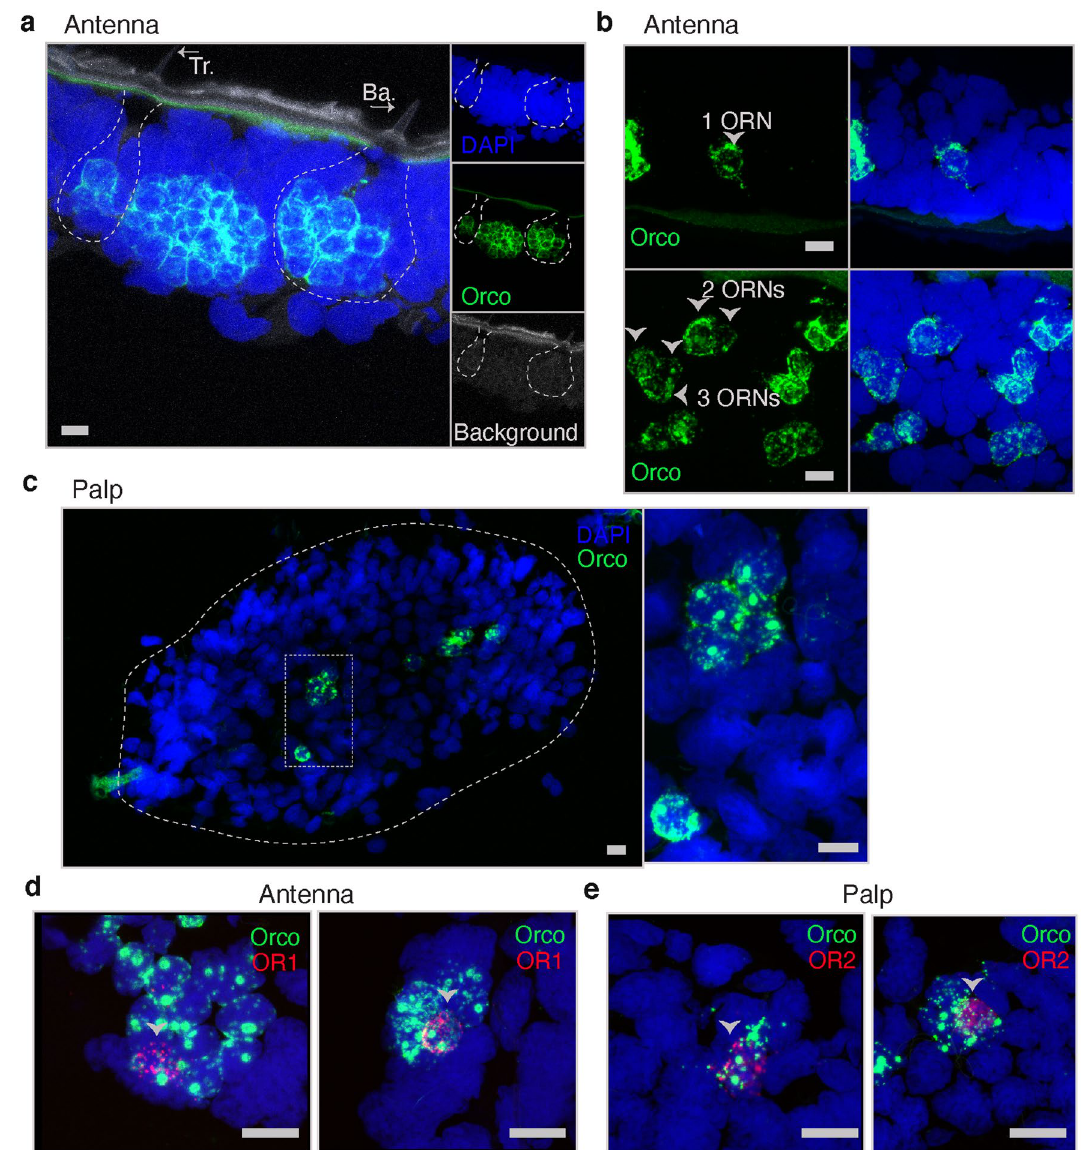
Figure 3. Expression of SameOrco, SameOR1, and SameOR2 in antenna and palp tissue sections, respectively. RNAscope in situ hybridization was used to characterize the spatial distribution of these putative ORs. ( a – c ) Probes against SameOrco (green) in antenna sections ( a , b ) and palp sections ( c ). Orco + cells in trichoid (Tr) and basiconic (Ba) sensilla are highlighted by arrows in panel a. Trichoid sensilla containing one, two, and three ORNs are depicted by arrows in panel ( b ). ( d , e ) SameOrco probe with the probe against the second most expressed putative SameOR in each tissue type were used. SameOR1 (antenna, panel d ) and SameOR2 (palp, panel e ) are present only in Orco + cells. Blue label in all images:DAPI. Scale bars: 10 μm in panels a – c ; 15 μm in panels d – e